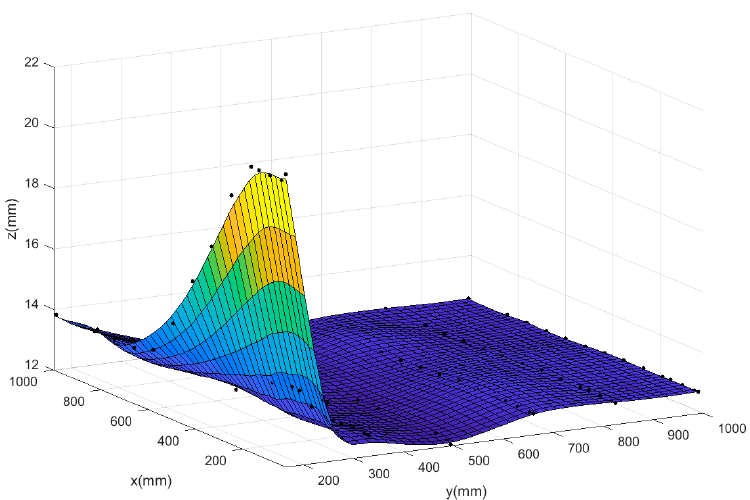
Figure 18. The predicted surface of the GA-Adam-BP neural network.